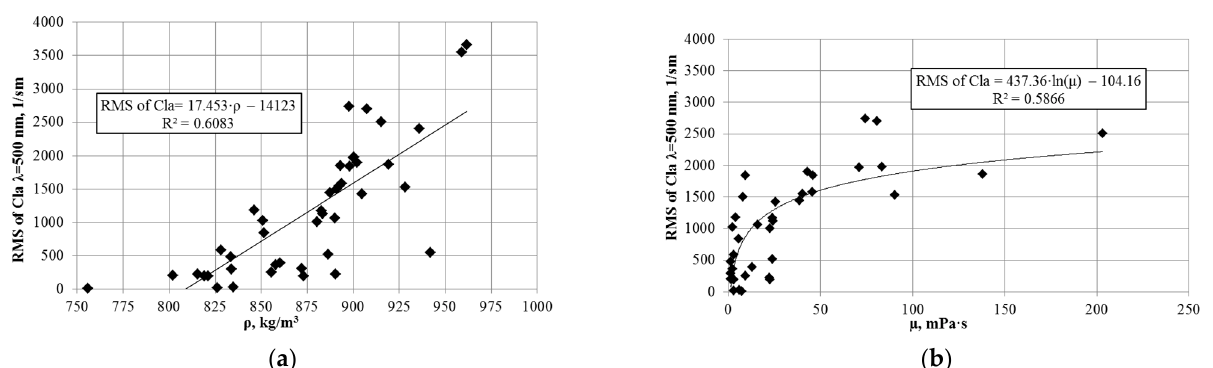
Figure 4. Coefficient of light absorbance variation vs oil production rate ( a ) and change of water cut of produced product ( b ) [101].